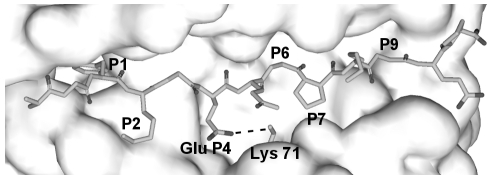
Model of huCollp261 peptide in the HLA-DR4 binding cleft.The computationally generated model closely resembles the hypothetical model suggested by Dessen et al. (22) for the DR4 recognition of huCollp261. Phe263 fits into the P1 pocket and Glu266 (P4) hydrogen bonds to Lys71β. The MHC peptide-binding groove is represented with Connolly solid surface, whereas the ligand peptide is shown in stick representation.